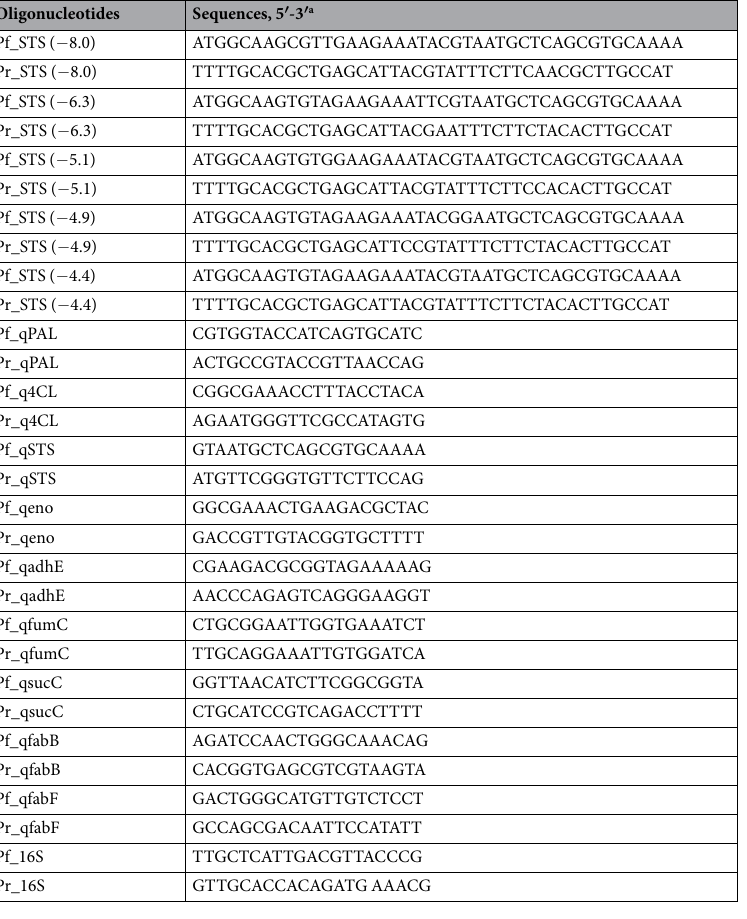
Table 2. Nucleotide sequences of primers. a Bold and underlined letters are restriction enzyme cut